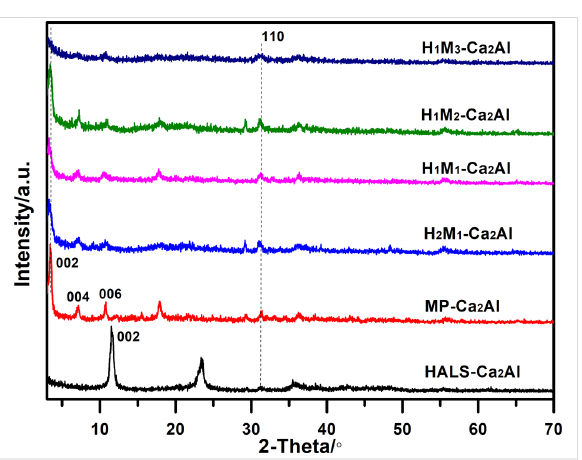
Figure 2: Powder X-ray diffraction patterns of different H n M n ′ -Ca 2 Al- LDH samples.